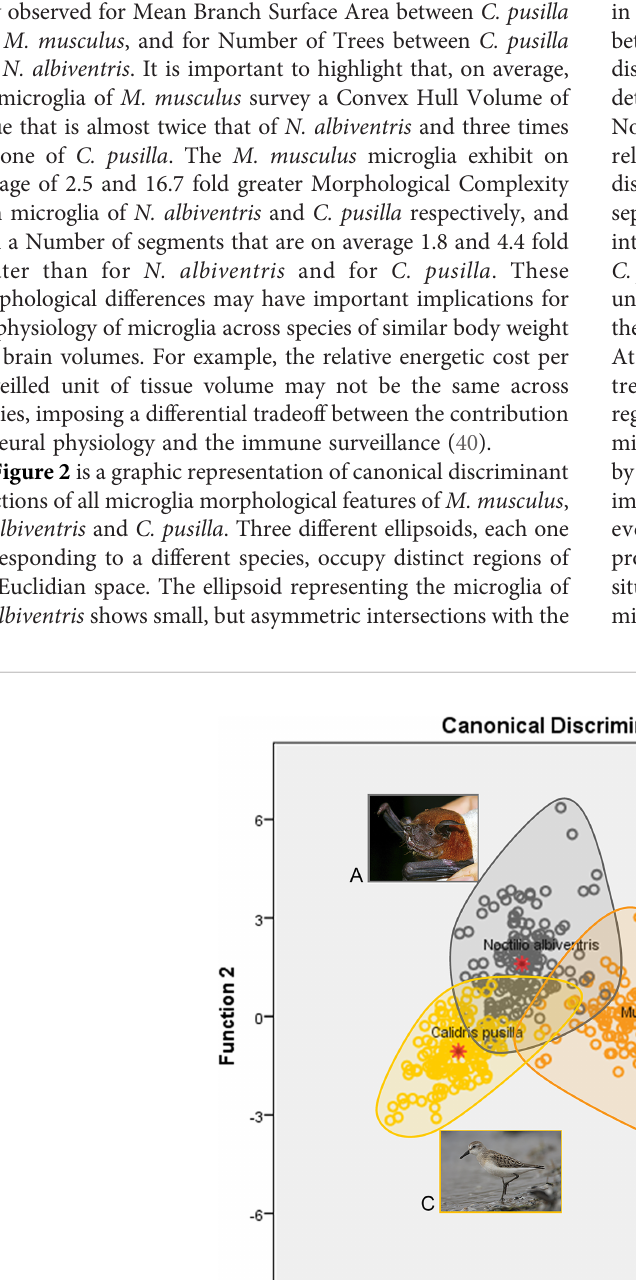
FIGURE 2 | Graphic representation of the canonical discriminant function analysis of three-dimensional microglia reconstructions in the dentate gyrus of N. albiventris (A) , M. musculus (B) and hippocampal V region of C. pusilla (C) . Open color circles illustrate the microglia distribution in each species. The ellipsoid for N. albiventris (gray circles) intercepts both M. musculus (orange) and C. pusilla (yellow), with a greater overlap with C. pusilla Function 1, explains 82.0% of the variance (for details of statistical analysis see Supplementary Material SM1